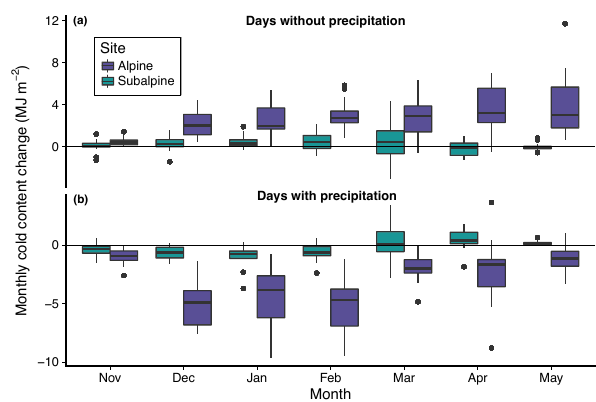
Figure 7. Simulated cold content gain and loss per month in the alpine and subalpine for days without precipitation (a) and days with precipitation (b) . Values above the zero line correspond to a loss of cold content (i.e., cold content approaches zero), while val- ues below correspond to a gain of cold content.